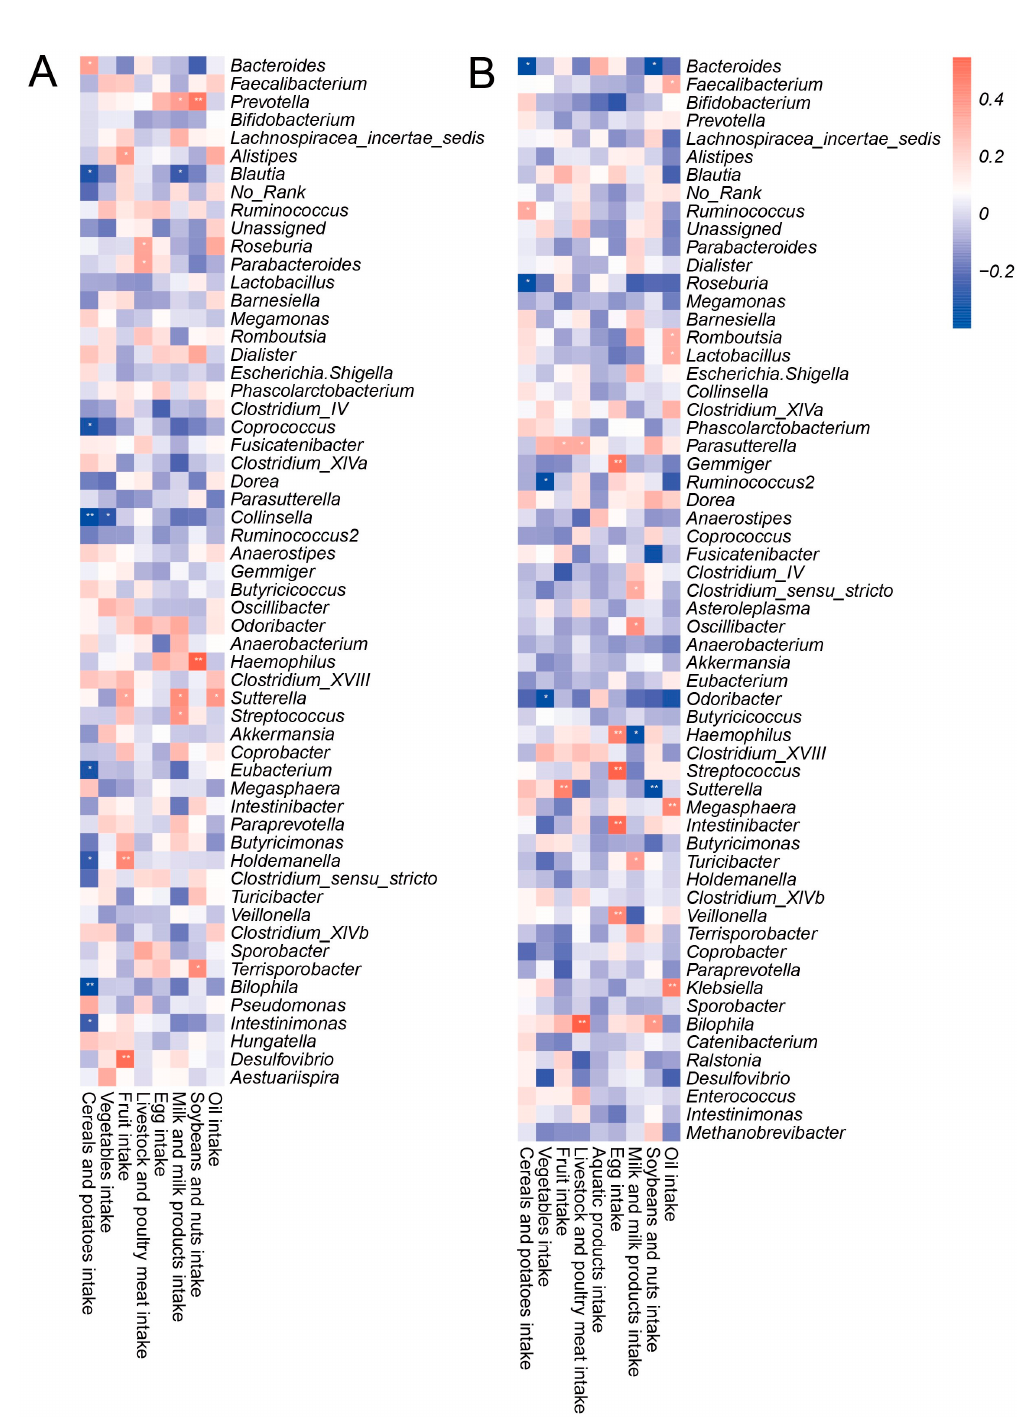
Figure 3. The relationship between genus-level bacterial taxa and dietary composition in ( A ) ZD group and ( B ) CK group. Only those genera with relative abundance >0.05% are shown. Two colors mean positive correlation and negative correlation, respectively.